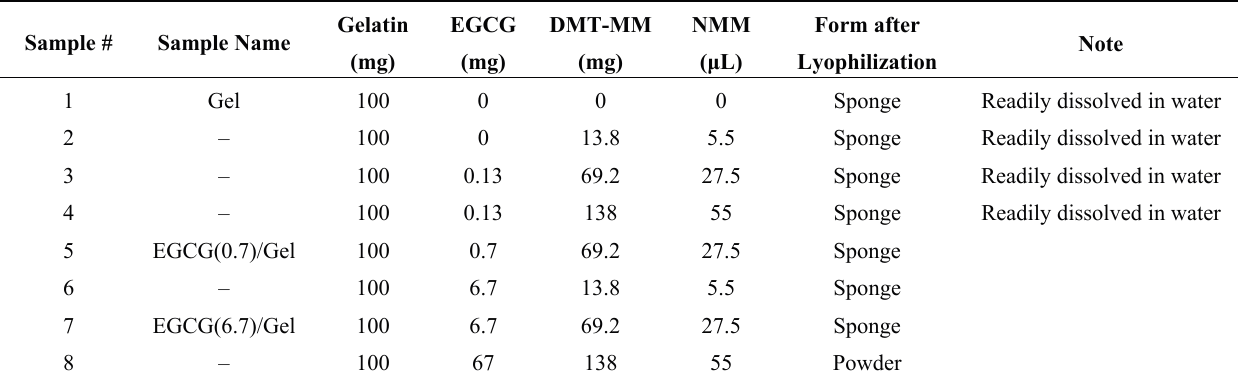
Table 1. Synthesis of EGCG/Gels. #: Nubmer.